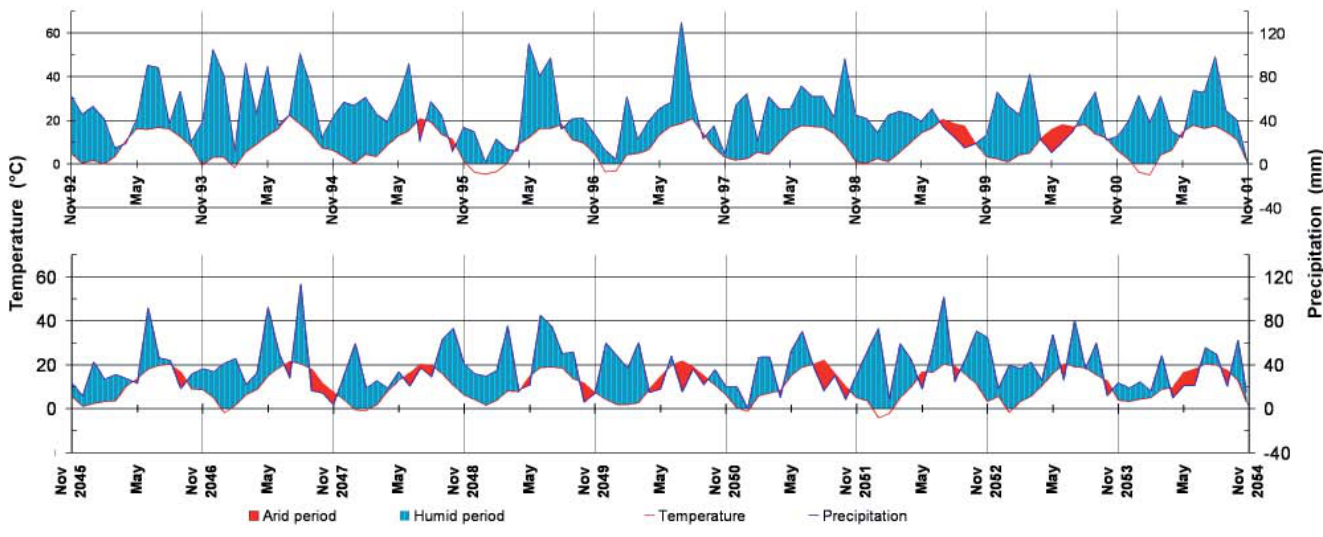
Figure 6. Time series of precipitation and temperature for Müncheberg station. Top: Initial Situation 2000, Bottom: Scenario 2050 (Gerstengarbe et al.,